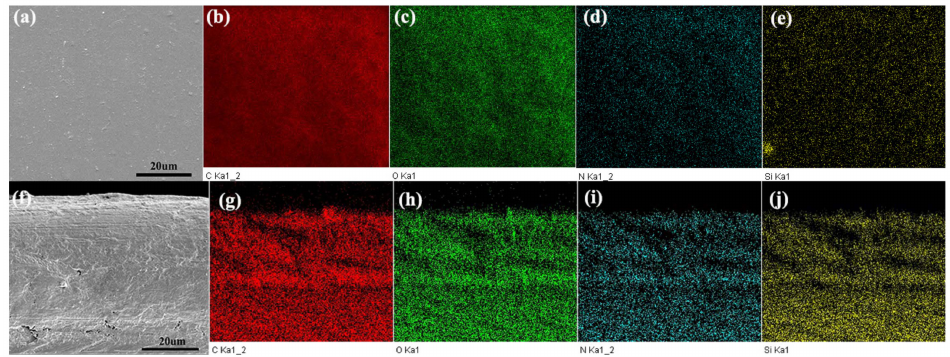
Figure 7. The EDS map scanning of surface ( a ) and cross-section ( f ) for 0.5 wt.% PVSQ-GO / WPU coating specimen, ( b , g ) C element, ( c , h ) O element, ( d , i ) N element, ( e , j ) Si element distribution.